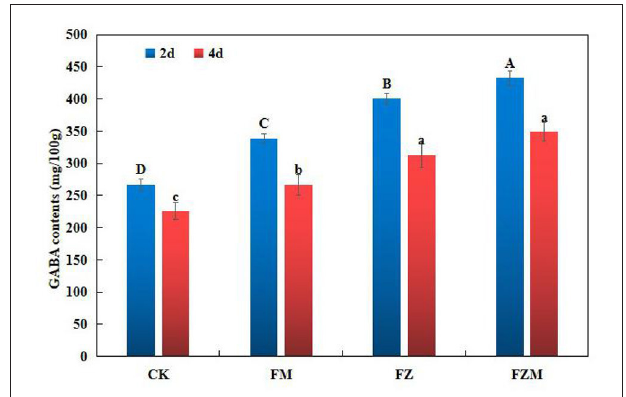
FIGURE 4 | GABA contents in adzuki beans in different germination processes. The soaking conditions of CK, FM, FZ, and FZM were 16h soaking, soaking temperature at 35 ◦ C, and pH value of 5. GABA contents were determined after germination for 2 d and 4 d. Data are mean ± SD ( n = 3). The upper- and lower-case letters in the figure reflect significant differences between the treatments at 2 and 4 d after germination ( p < 0.05). CK: Control treatment (31 ◦ C for 4 days); FM: CK + 2 mg/ml MSG treatment; FZ: CK + 15h vacuum treatment; FZM: CK + 15h vacuum + 2 mg/ml MSG treatment (sprayed every